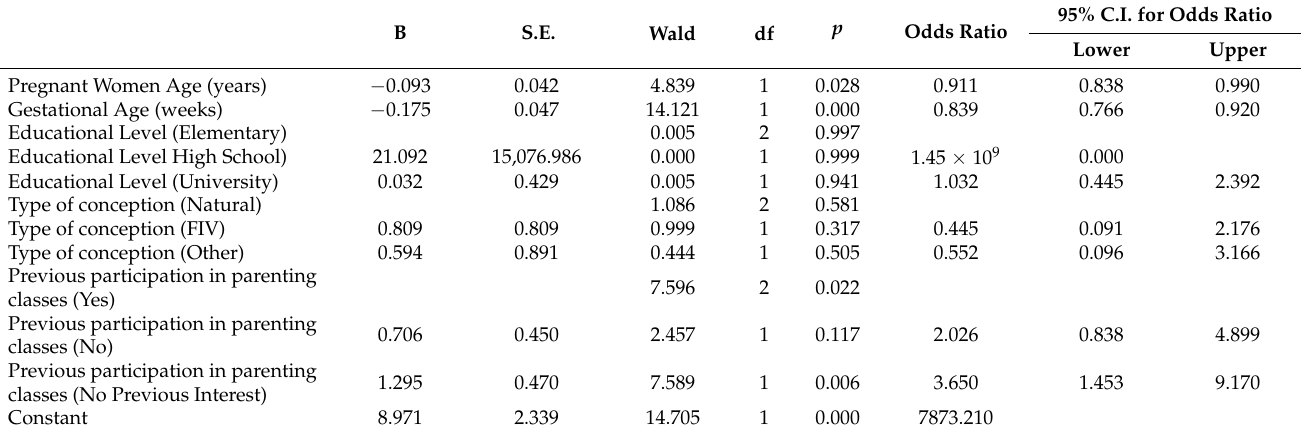
Table 3. Logistic regression predicting likelihood of vaccination in pregnant women based on age, gestational age, educational level, type of conception and previous participation in parenting classes. B S.E.